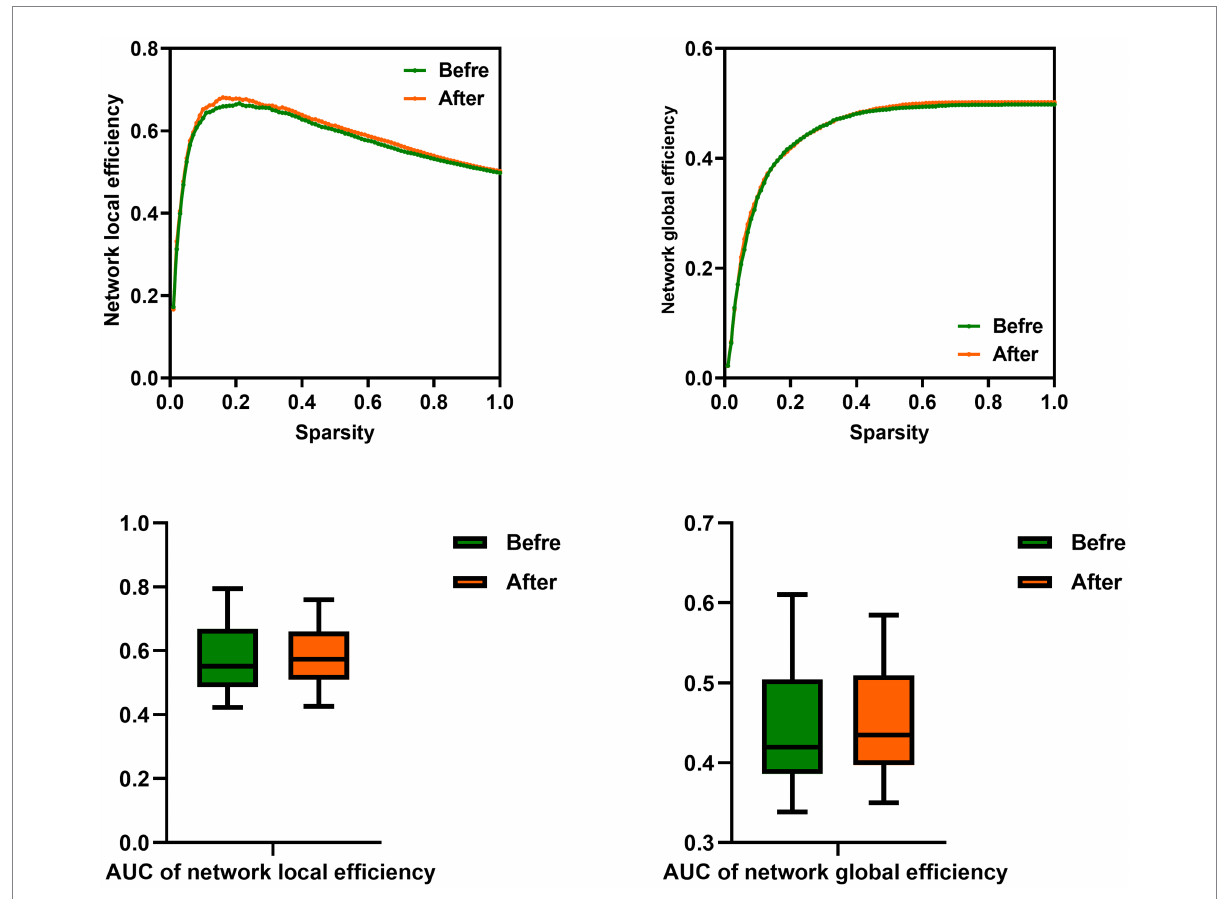
FIGURE 3 Comparison of network efficiency of male rowing athletes before and after tDCS. AUC, area under the curve; tDCS, transcranial direct current stimulation. Values of p were obtained by paired t tests. p < 0.05 indicated statistically significant